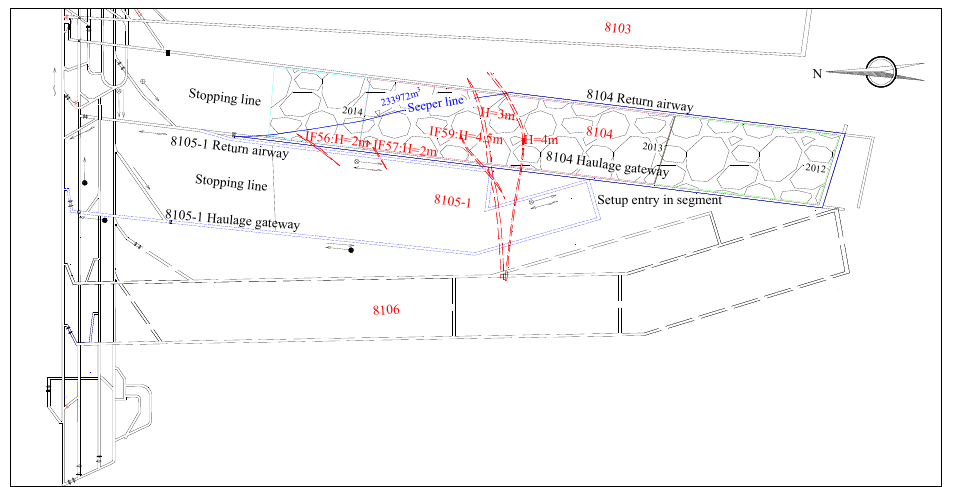
Figure 1. Position, production system, and geological structure of 8105-1 working face.